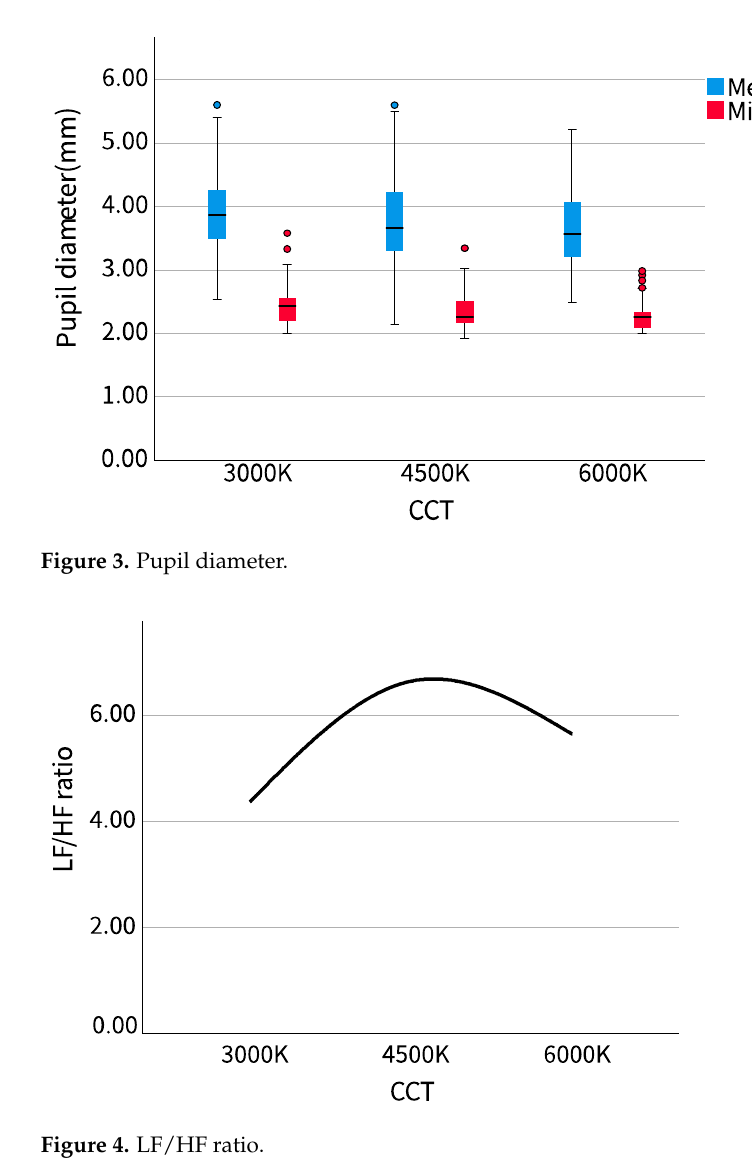
Table 2. Cross examination of psychophysiological variables. Mean Pupil Diameter